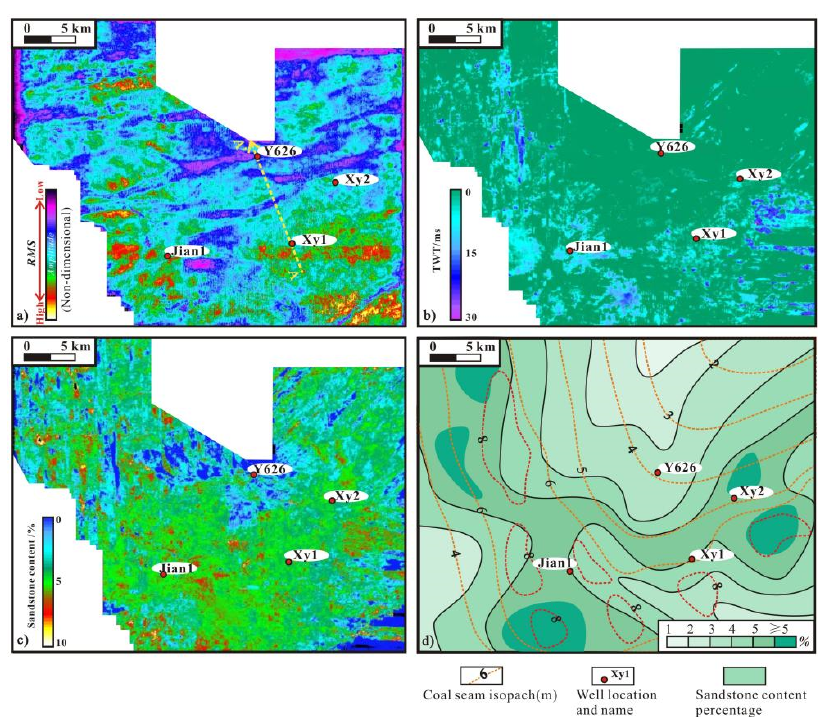
Figure 5. ( a ) RMS amplitude map of the Taiyuan Fm. in a 3D seismic survey in the southeastern Ordos Basin; ( b ) Inversion coal seam time-domain thickness map of the Taiyuan Fm. in a 3D seismic survey; ( c ) Inversion sandstone content percentage map of the Taiyuan Fm. in a 3D seismic survey; ( d ) Coal seam isopach map superposed by the sandstone content percentage contours of the Taiyuan Fm. in a 3D seismic survey.